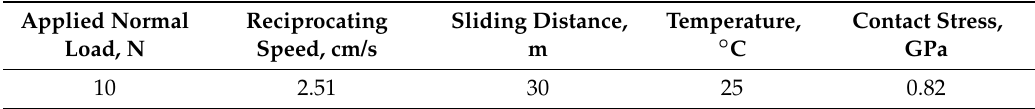
Table 3. Wear test conditions under dry